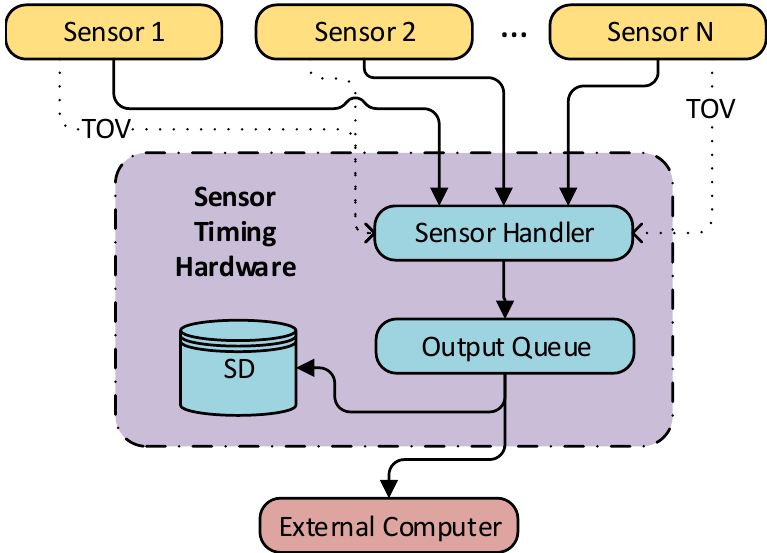
Figure 4. Proposed modularization of a hardware sensor timing system, which is modularized by